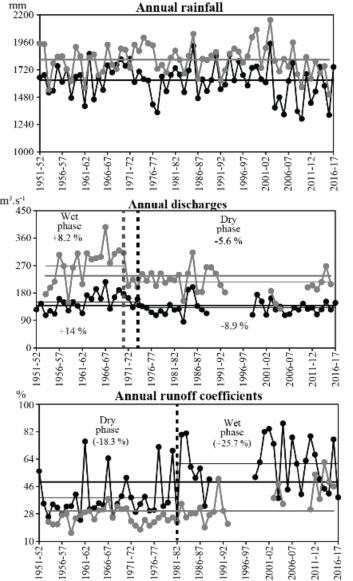
Figure 3. Results of statistical segmentation of Nyong (black) and Ntem (gray) annual rainfall, discharges and runo ff coe ffi cients, according to the Pettitt test. The thick horizontal lines indicate the averages of the whole period, while the thin horizontal lines indicate those of the di ff erent homogeneous periods. The thick and broken vertical lines indicate the years of